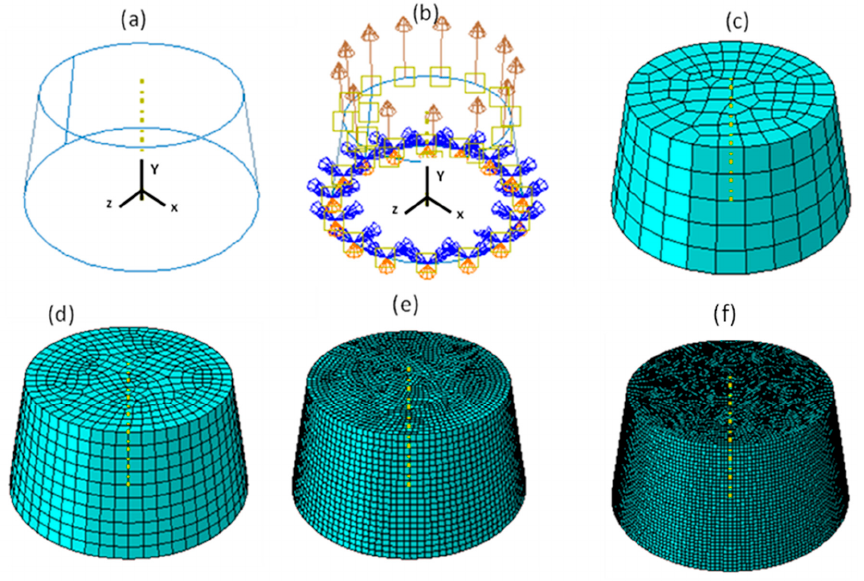
Figure 12. ( a ) A three-dimensional (3D) numerical model for the necking of a circular bar with ( b ) imposed loading and boundary conditions, ( c ) 2 mm mesh size (475 elements), ( d ) 1 mm mesh size (3550 elements), ( e ) 0.5 mm mesh size (28320 elements), and ( f ) 0.25 mm mesh size (126038 elements).